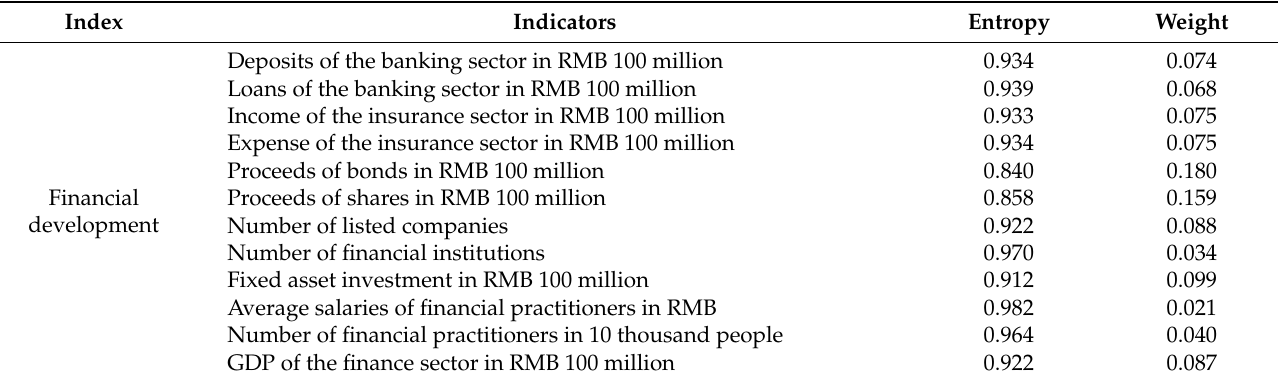
Table 1. Entropy weighting of financial development